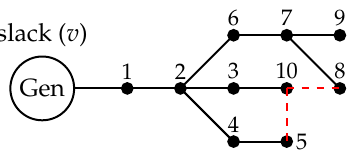
Figure 2. Electrical diagram of the 10-bus test